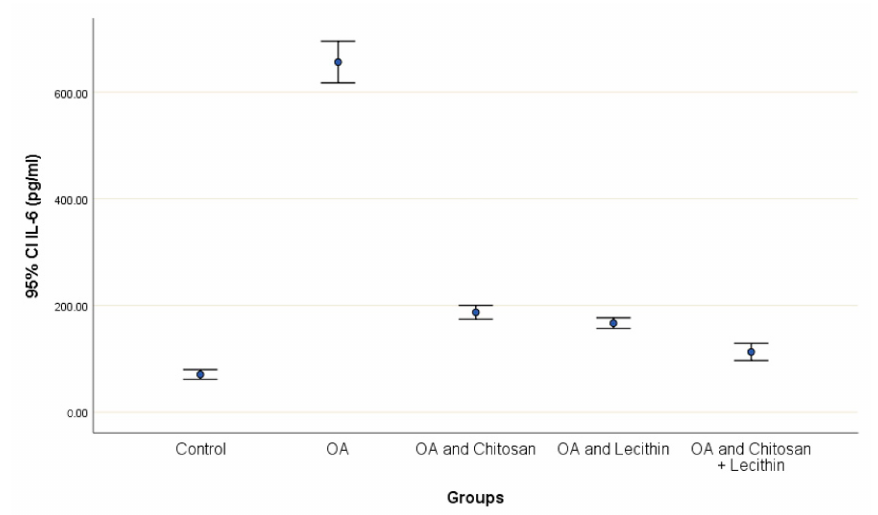
Figure 3. The e ffi cacy of chitosan and lecithin against interleukin-6 (IL-6) in (OA) model that was induced by monoiodoacetate (MIA). The data presented as mean ± S.